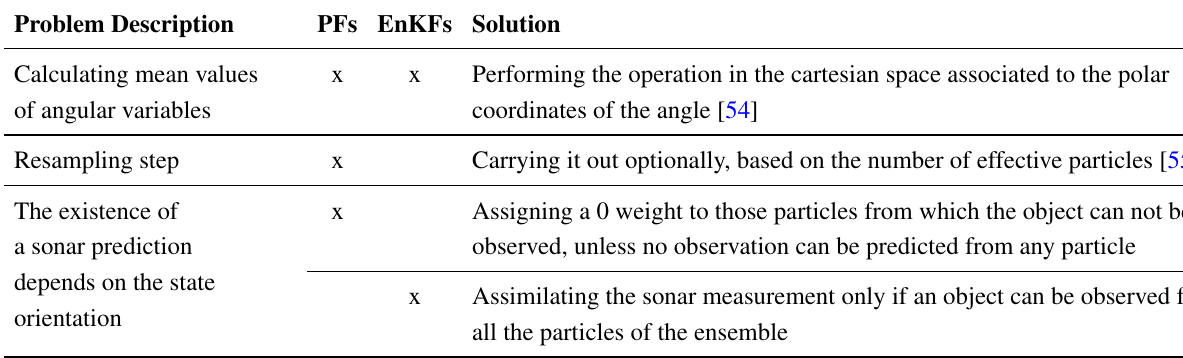
Table A1. Relevant additional aspects to implement the OOS PFs and